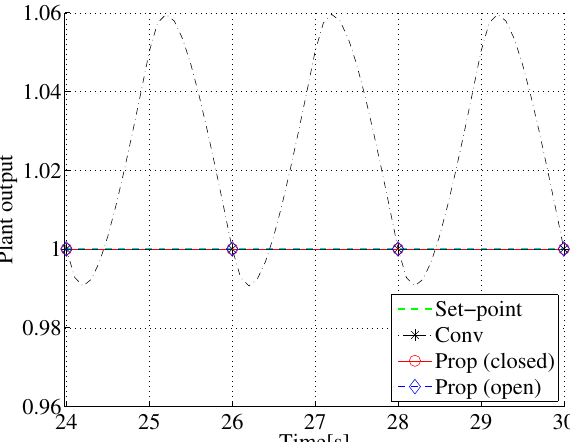
Figure 6. Steady-state trajectories for data in Figure